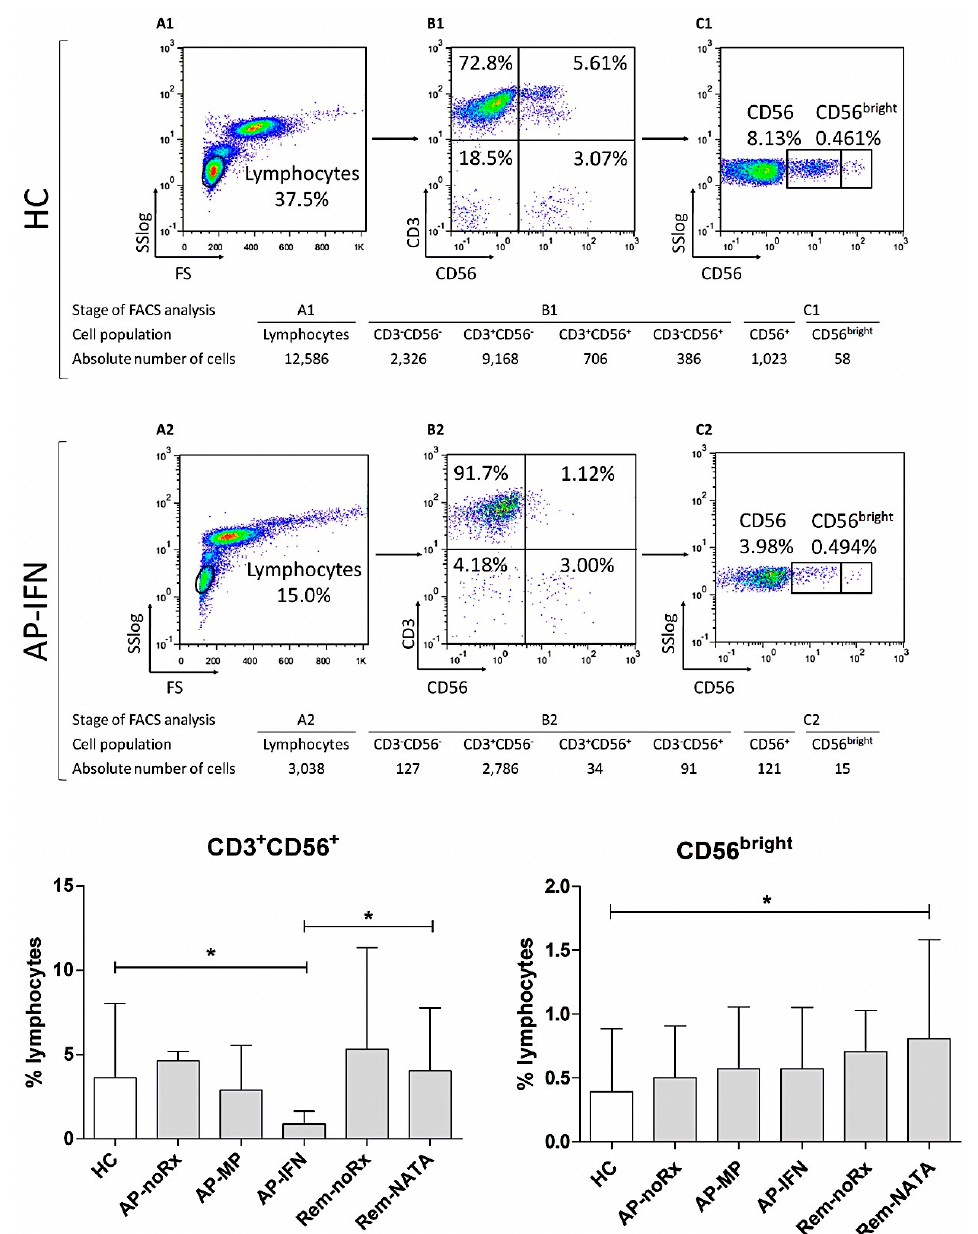
Figure 4. Flow cytometric analysis to determine CD3 + CD56 + and CD56 bright RC levels in human peripheral blood. A representative analysis is shown for one healthy control ( A1 – C1 ) and one RRMS patient in the acute phase under interferon β (AP-IFN) treatment ( A2 – C2 ); The WBC were gated on lymphocytes, based on forward and side light scatter ( A1 , A2 ), and analyzed for CD3 and CD56 expression ( B1 , B2 ); The CD56 positive cells were further analyzed for the intensity of CD56 expression (CD56 bright ) ( C1 , C2 ); The numbers in the dot plots indicate the percentage of gated cells expressing the relevant marker. The tables underneath, show the absolute number of cells in each population analyzed; Bottom graphs : The results of the analysis of all patients ( n = 83) and controls (HC, n = 45). ( Left ) CD3 + CD56 + ; ( Right ) CD56 bright . For abbreviations see legend of Figure 1. * p = 0.05.